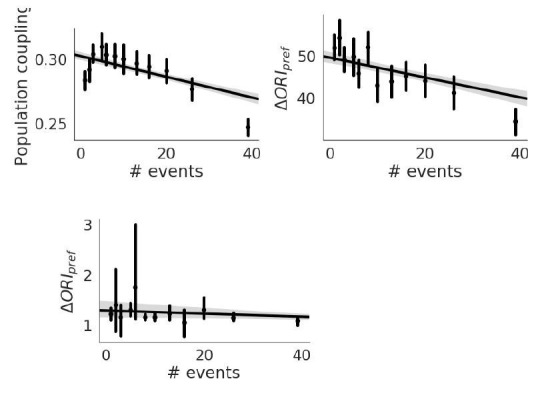
Population Coupling.